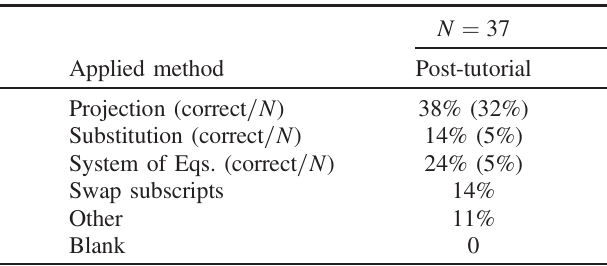
TABLE III. A list of the different methods students used to change basis and the percentage of each method on the final exams at University A. For the three methods that can lead to correct answers, the percentage of students would applied that method and arrived at the correct answer are shown for each